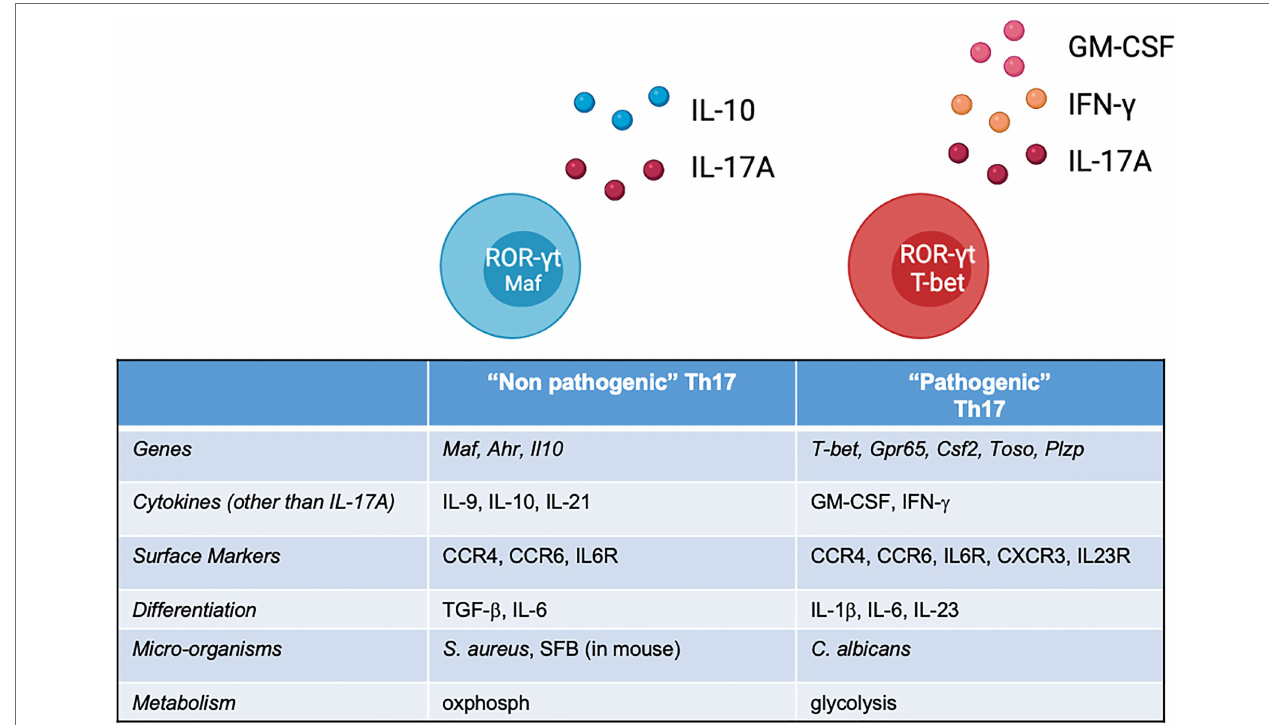
FIGURE 1 | List of features of ‘non-pathogenic’ and ‘pathogenic’ Th17 cells identified across several studies, most of which performed on murine cells. In vivo , this classification should not be considered bimodal, but rather a continuum of states, shaped by the local